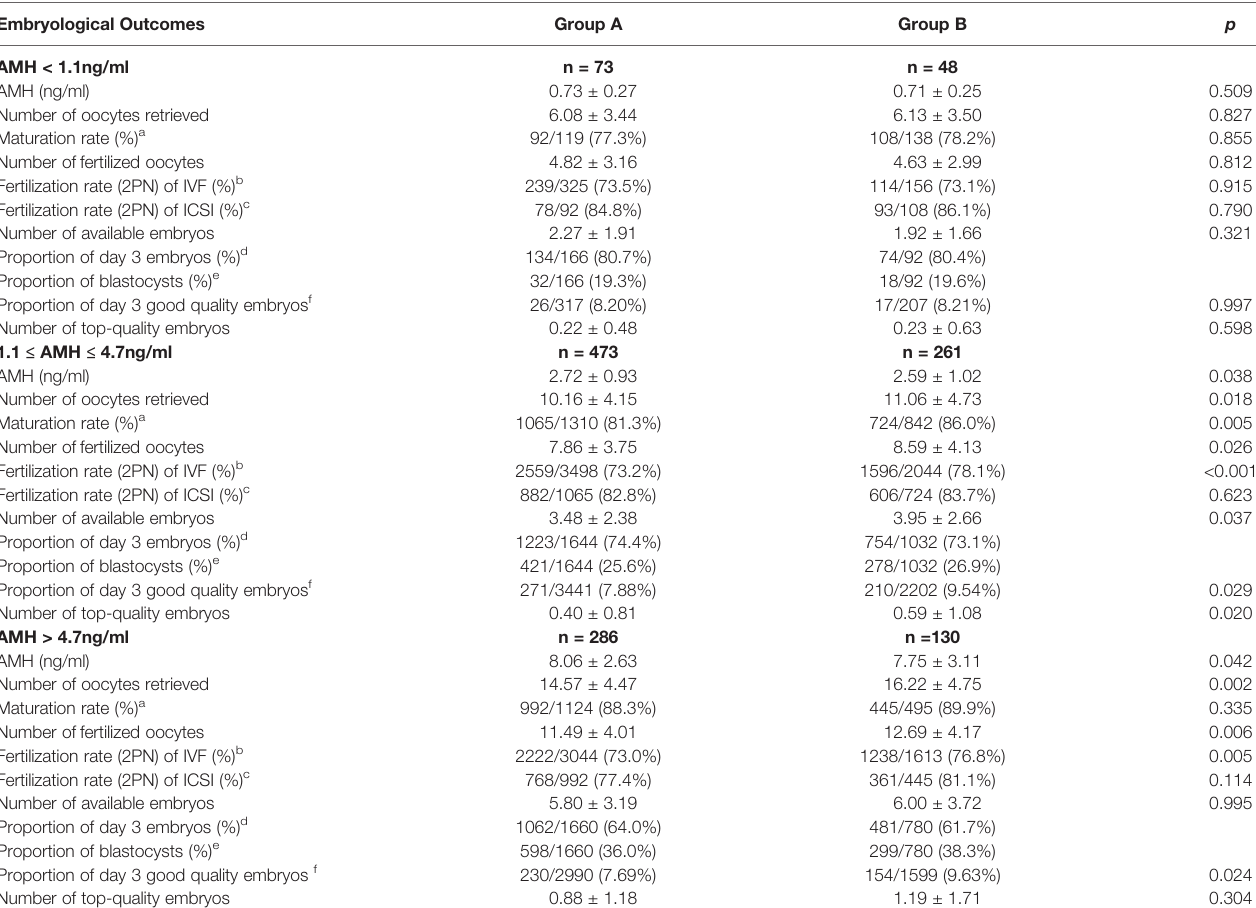
TABLE 4 | Embryological outcomes of the participants based on AMH subgroups. Embryological